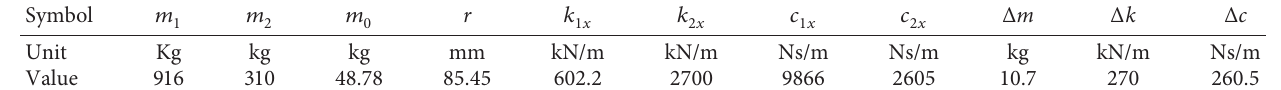
Table 1: The parameters of the vibrating flip-flow